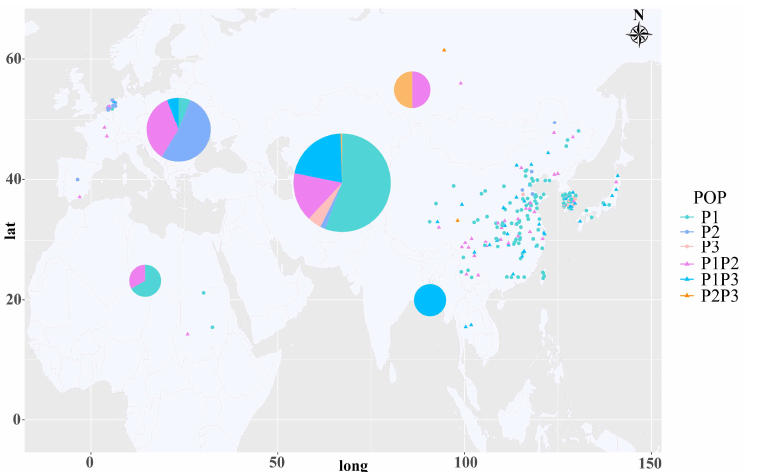
Figure 3. Geographical distribution of collected 217 radish accessions. Different colors represent different populations. P1, turquoise; P2, cornflower blue; P3, pink; P1P2, purple; P1P3, deep-sky blue; P2P3, orange. The regions represent East Asia, Western Europe, North Africa, Southeast Asia, and Russia in pie chart. The color size in each pie chart is proportion to radish accessions number in certain population. The number of the radish accession in each province of China was preliminarily shown in the figure, and the corresponding detailed formation was displayed in Figure S1.